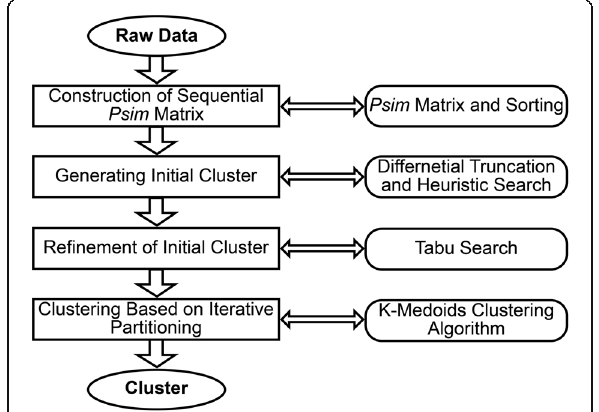
Fig. 1 Framework of the proposed clustering